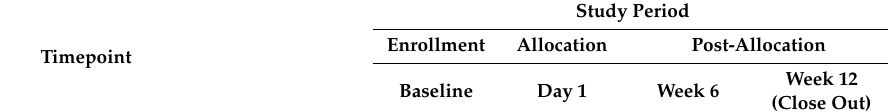
Table 1. Standard Protocol Items: Recommendations for Intervention Trials (SPIRIT) diagram of enrollment, interventions, and assessments by participant type across both phases of the study.